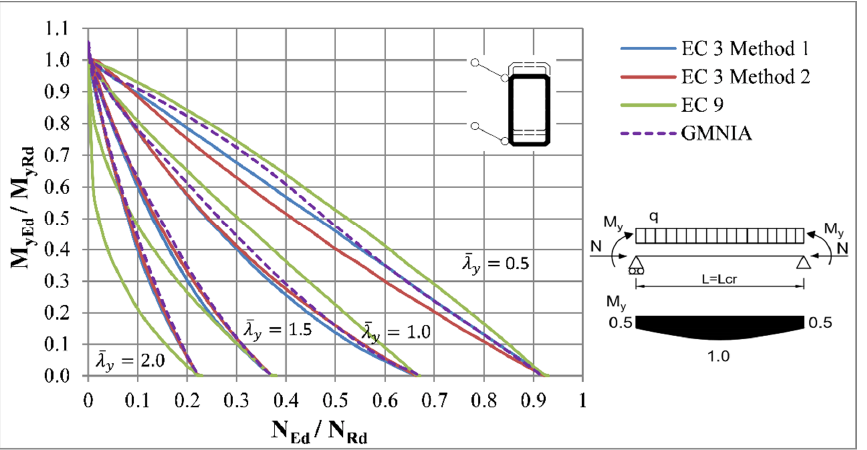
Figure 37. Interaction curves for laterally restrained beam-columns with RHS cross-section.